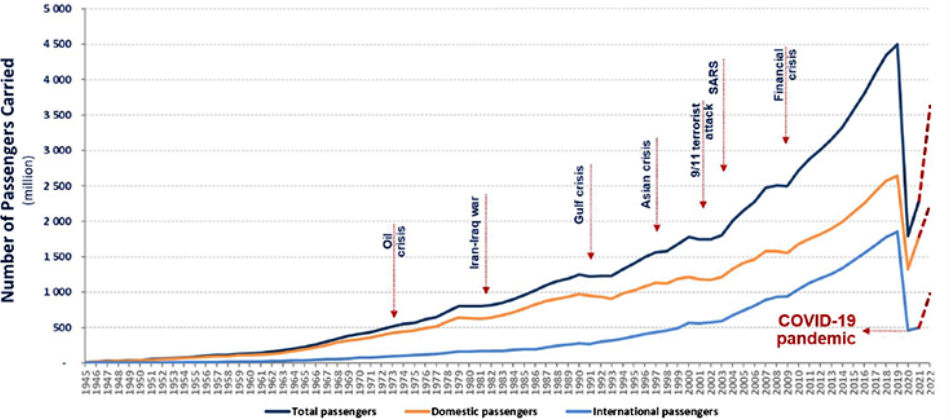
Figure 1. Global passengers carried from 1945 until 2022 projections. Adapted from [12].